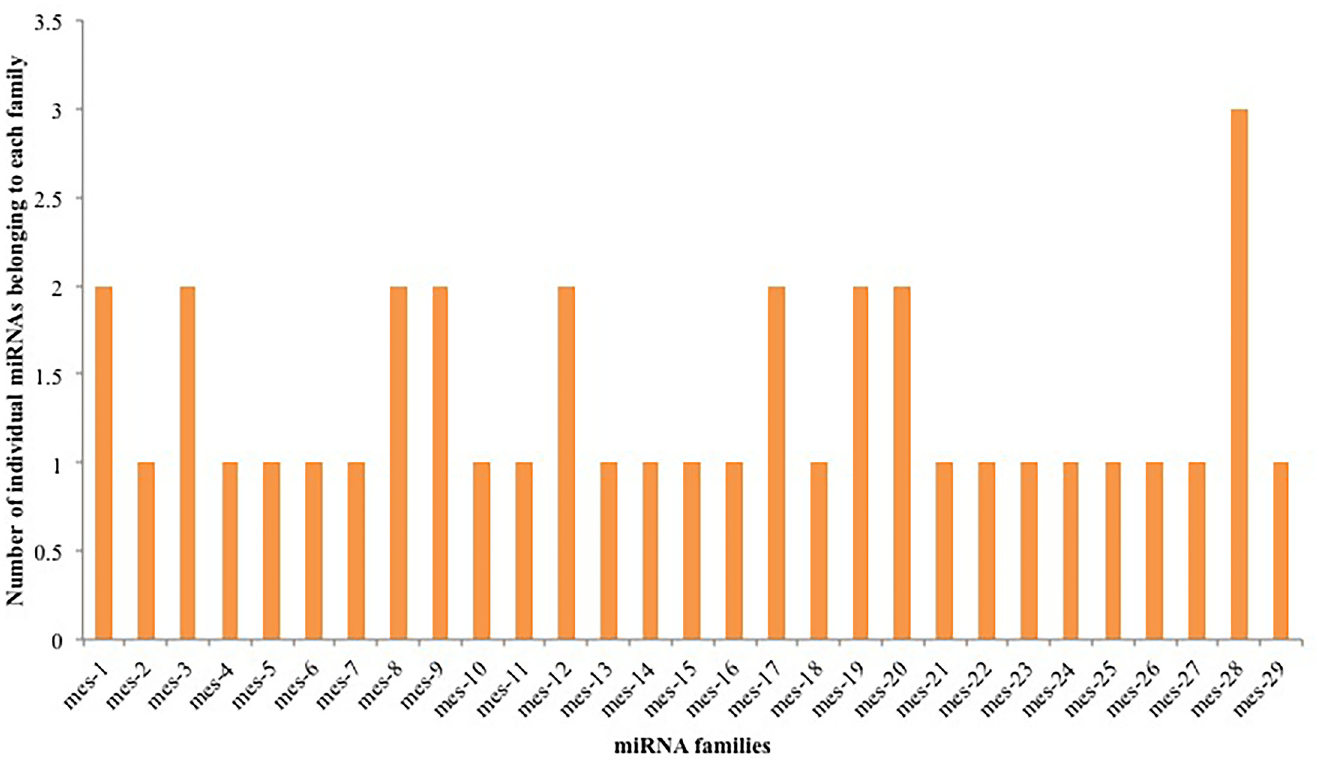
Fig 6. The number of individual cassava-specific miRNAs belonging to each novel miRNA family identified in cassava using NGS